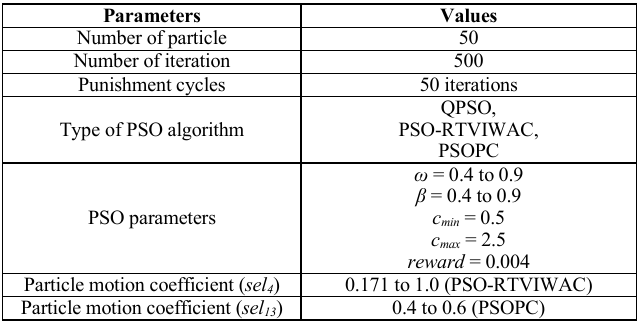
TABLE II. S UMMARY OF SIMULATION